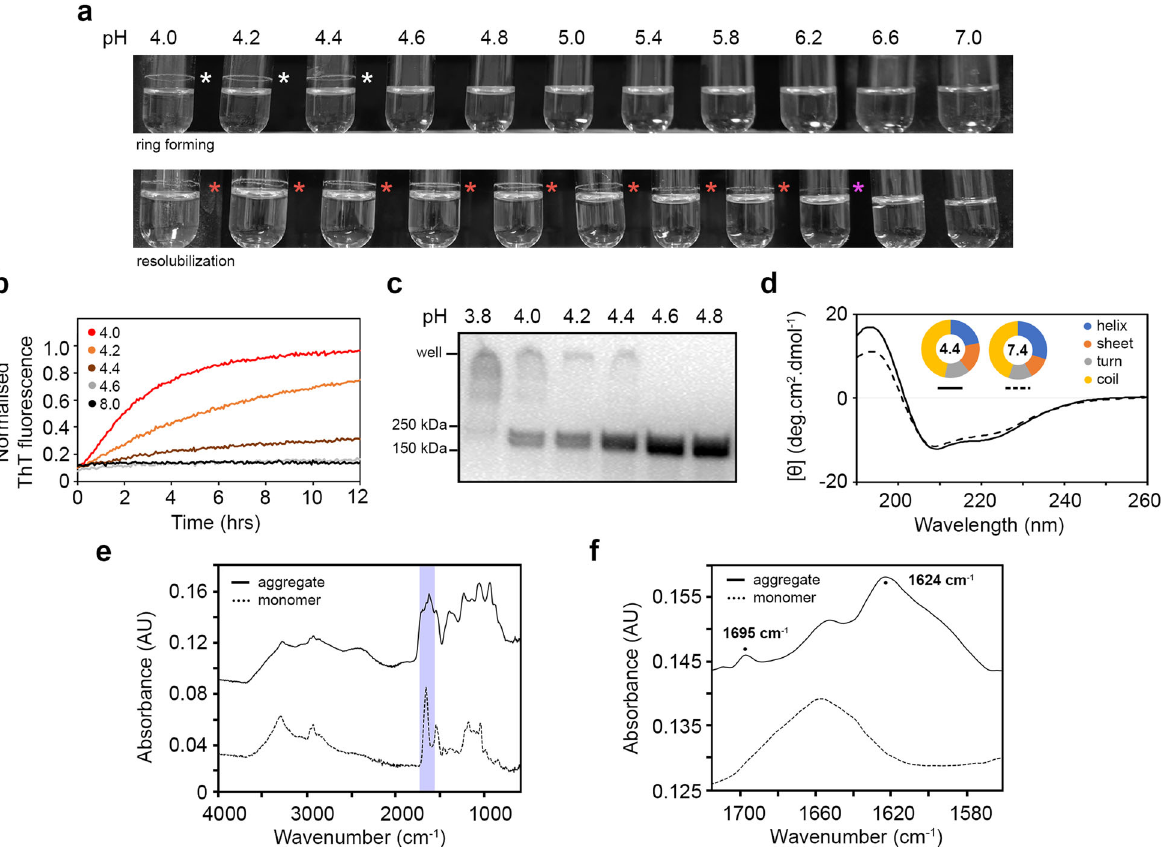
Fig. 2 Characterisation of SslE aggregates. a Puri fi ed rSslE forms a clear ring of aggregated protein when incubated in the citrate-phosphate buffer between pH 4.0 and 4.4 (upper panel; white asterisks). The ring formed above the liquid line is due to shaking of the sample and it resists solubilisation up to pH 6.2 once formed (lower panel; purple asterisk), although some loss of protein band is observed after pH 5.8 (lower panel; red asterisks). b Increase in ThT fl uorescence emission on binding to rSslE aggregates formed in citrate-phosphate buffer over pH 4.0 – 8.0. c Immunoblot of rSslE incubated in citrate-phosphate buffer from pH 3.8 to 4.8 and detected with anti-His 6 antibody. rSslE present in the well represents an aggregated protein. Blots were derived from the same experiment and processed in parallel. d Far-UV CD spectra of soluble rSslE at pH 4.4 (solid line) and 7.4 (dashed line). Secondary structure analysis is shown in the doughnut chart. e ATR FT-MIR spectrum of monomeric rSslE and aggregates with the amide I region shaded in violet. f Expanded ATR FT-MIR amide I region displaying the relatively high and low-intensity absorption bands in the aggregates but not monomeric spectrum at ~1624 and 1695 cm − 1 , respectively, characteristic of an anti-parallel β -sheet structure. Spectra are offset in the absorbance axis for